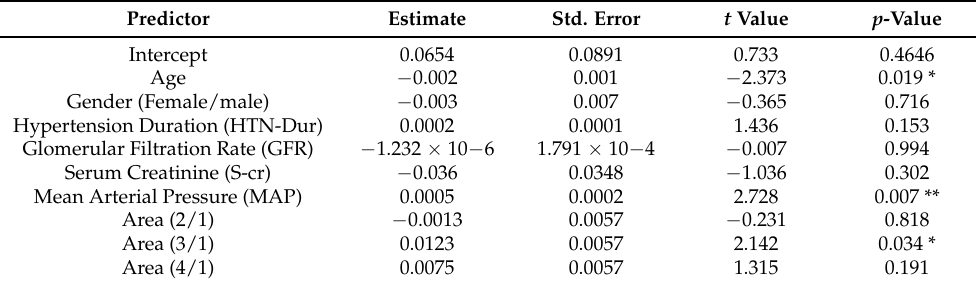
Figure 4. The red curves are the fitted functions for the model: Y = f BMI ( BMI ) + f UPE ( UPE ) + f A 1 C ( A 1 C ) + f BUN ( BUN ) + Age ∗ β Age + HTN − Dur ∗ β HTN − Dur + GFR ∗ β GFR + S − cr ∗ β S − cr + MAP ∗ β MAP using the Tilted Additive Model (TAM) approach to estimate f j . The shaded areas represent point-wise nonparametric bootstrap confidence intervals. Table 3. The linear part of the final model; ** significant at 0.01, * significant at